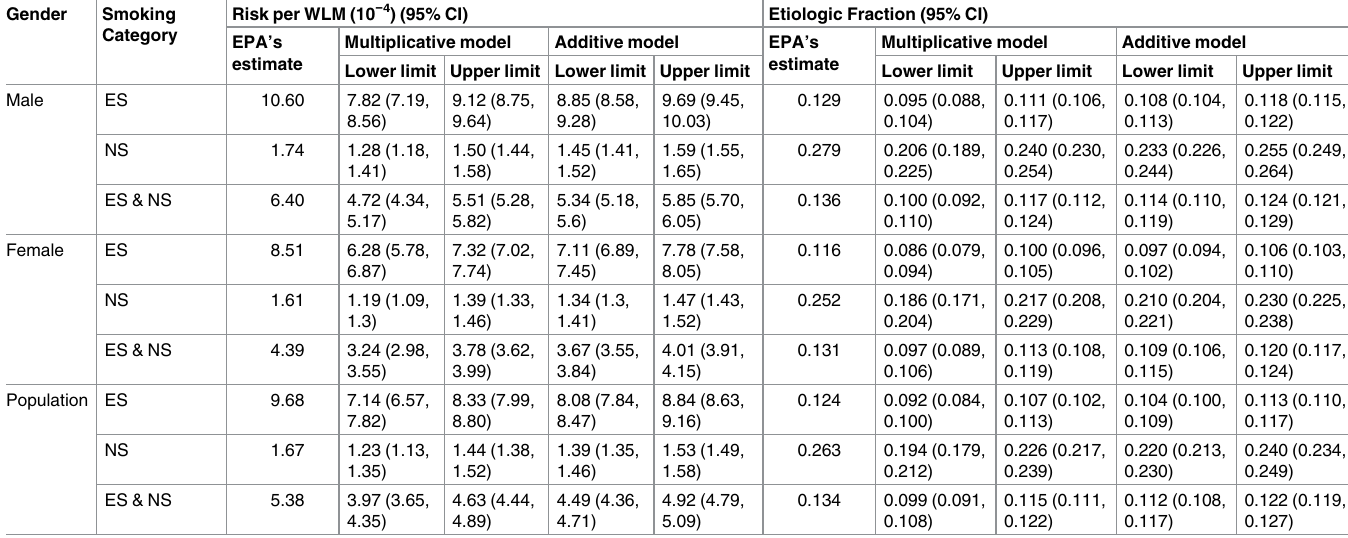
Table 3. Modified EPA’s estimatesof the risk per WLM and the